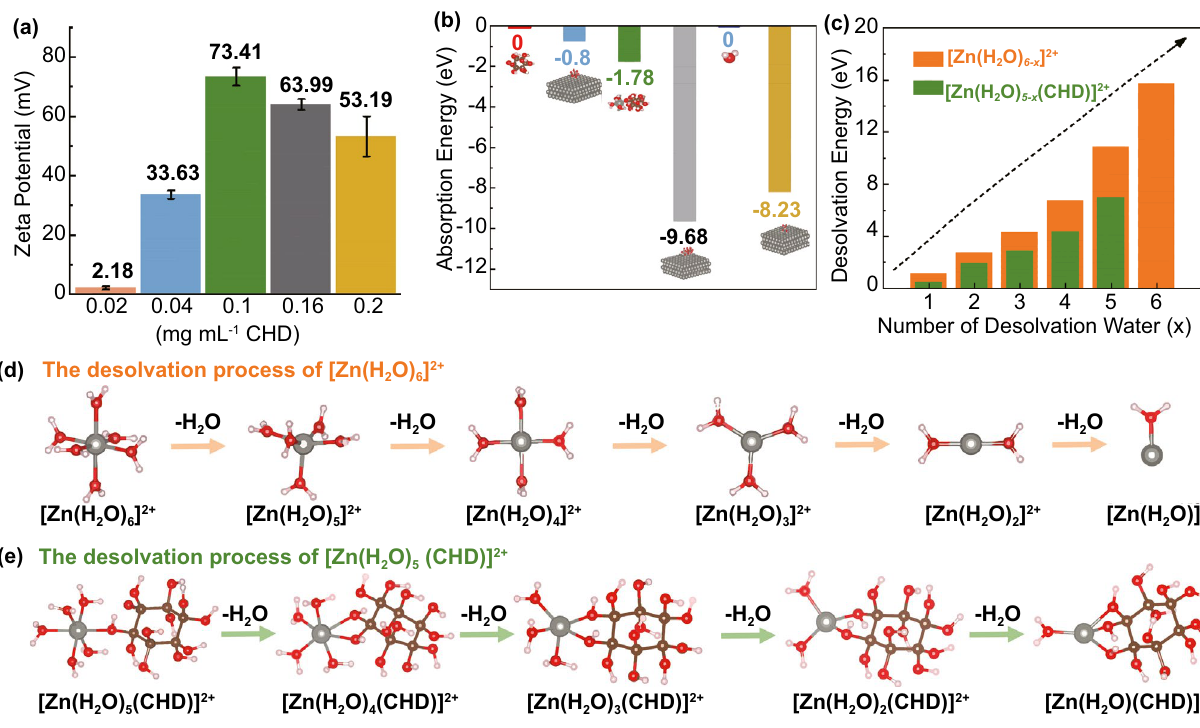
Fig. 4 a The distribution of the Zeta potentials of Zn 2+ with different amounts of CHD in ZnSO 4 aqueous electrolyte with attached error bars. b The energy comparison of CHD, [Zn(H 2 O) 5 (CHD)] 2+ , and [Zn(H 2 O) 6 ] 2+ on Zn (001) crystal plane or solution, which is based on the energy zero point of CHD and H 2 O molecules. Insertion is the corresponding absorbed models or dissolved model. The red, blue, green, gray, light blue, and yellow columns and related values are represented as CHD in the solution, CHD on the Zn surface, [Zn(H 2 O) 5 (CHD)] 2+ in the solu‑ tion, Zn(H 2 O) 5 (CHD)] 2+ on the Zn surface, H 2 O in the solution, and [Zn(H 2 O) 6 ] 2+ on the Zn surface, respectively. c The desolvation energies of